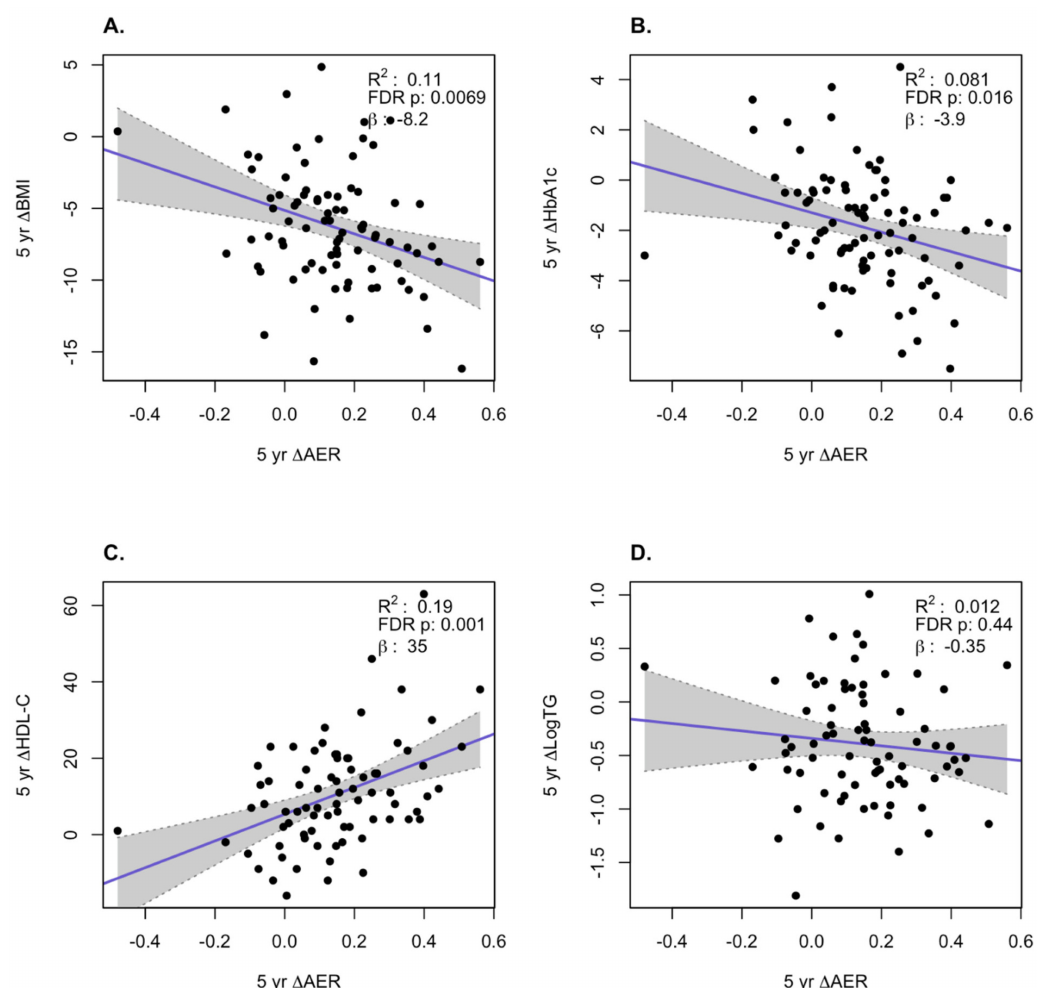
Figure 4. Correlation of changes of apoA1 exchange rate assay (AER) with changes in clinical variables at 5 years. Changes in BMI ( A ), HbA1c ( B ), HDL-C ( C ), and log TG ( D ). The gray region is the 95% confidence